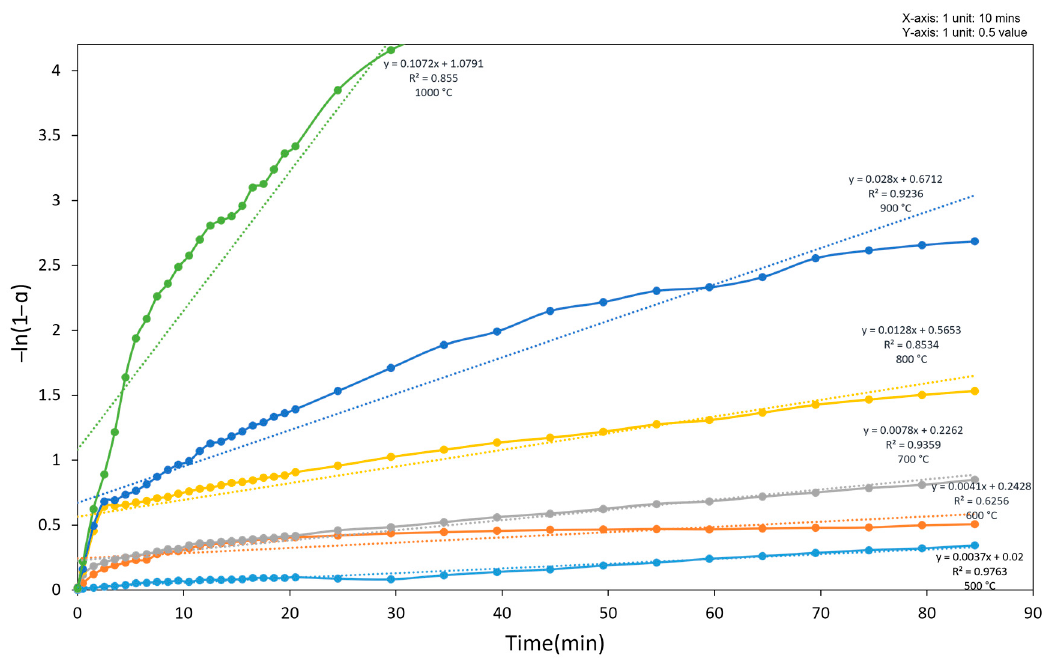
Figure 18. Relation between − ln(1 − α ) and time for different reduction temperatures.